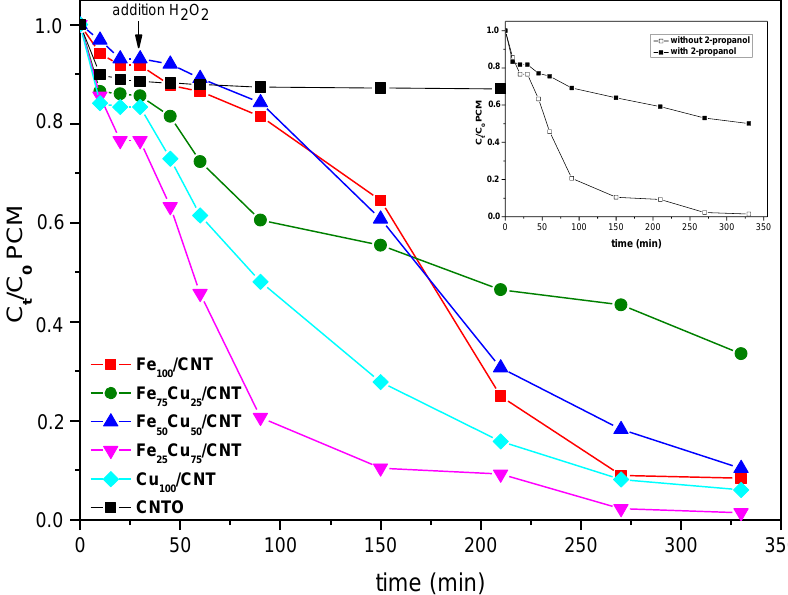
Figure 5. Decomposition kinetics of paracetamol (PCM; C 0 = 50 mg / L) at 25 ◦ C on Fe 100 − x Cu x / CNT samples. C 0 of H 2 O 2 : 13.8 × 10 − 3 mol / L. Initial pH: 6.3–6.6. Inset: Decomposition kinetics of PCM for Fe 25 Cu 75 / CNT catalyst in the presence and absence of 2-propanol.